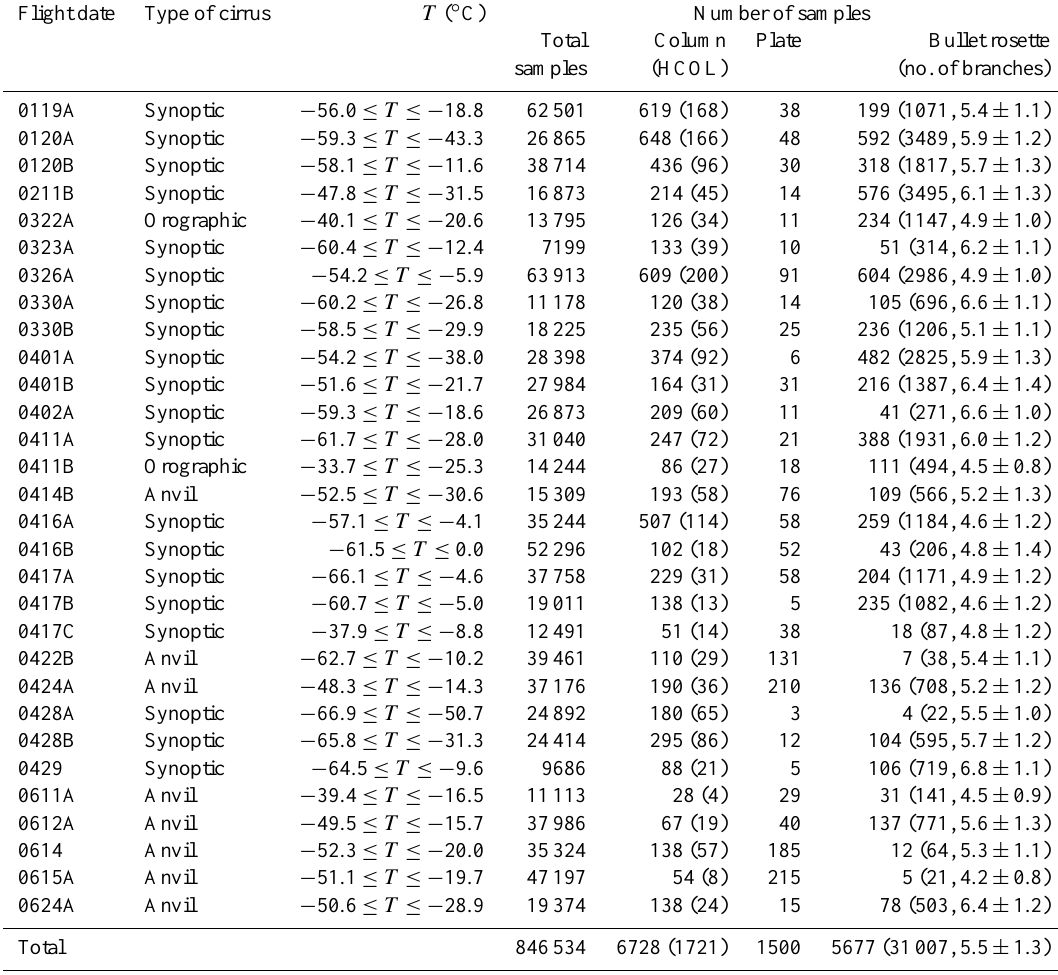
Table 5. Same as Table 4 but for SPARTICUS.